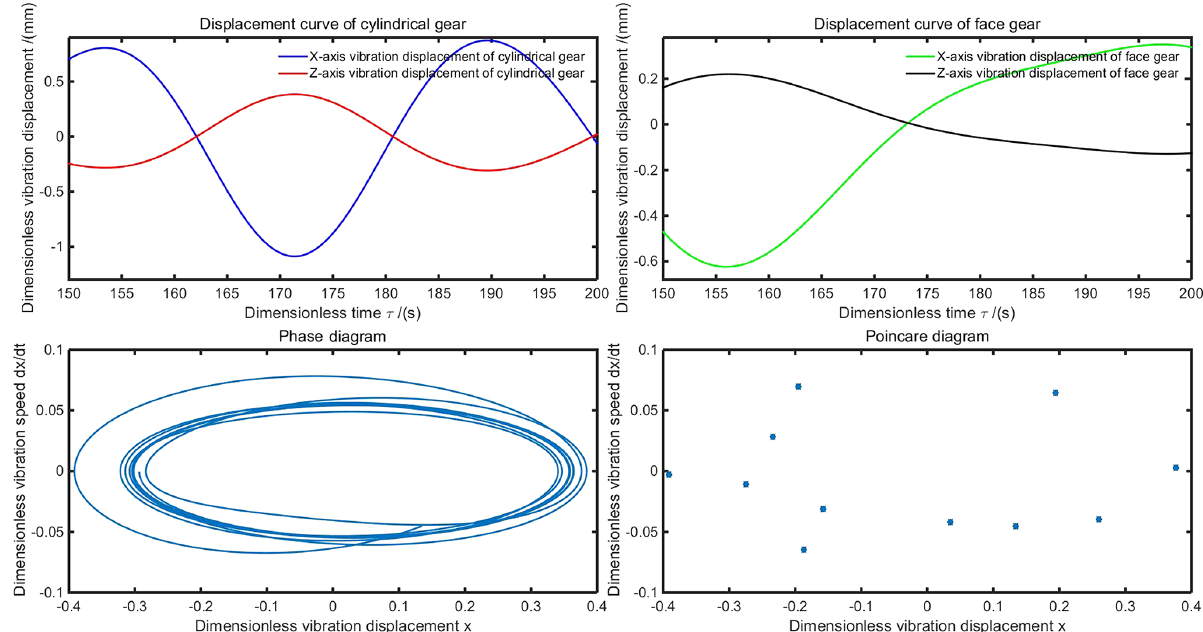
Figure 20. Displacement, phase, and Poincare diagrams of nonlinear system with excitation frequency 0.1648.